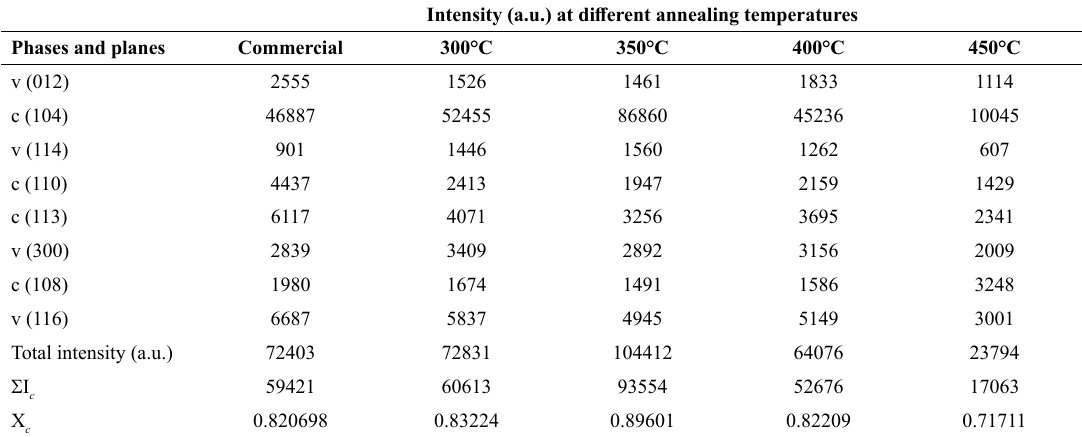
Table 1. Calculated phase ratio vs. annealing temperature of desired CaCO